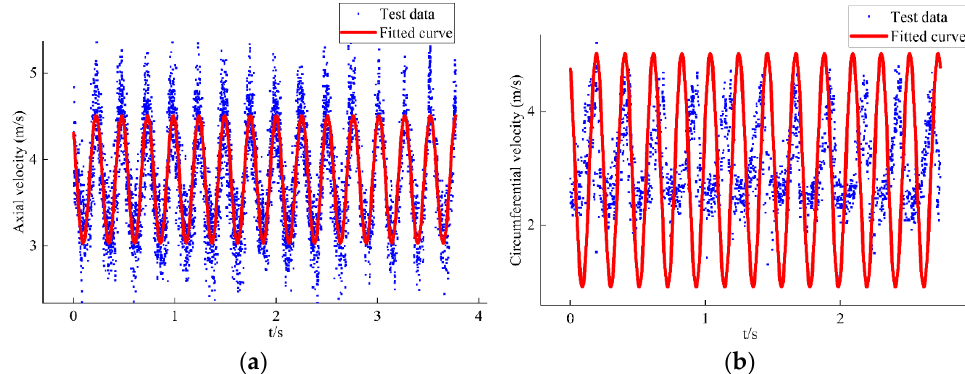
Figure 17. Transient velocities. ( a ) Axial velocity, ( b ) circumferential velocity.